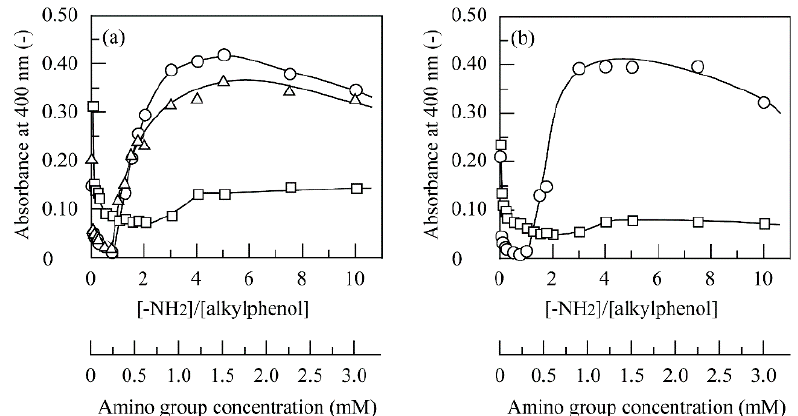
Figure 8. Changes in the absorbance at 400 nm with the amino group concentration for removal of ( a ) 4NBP ( ○ ), 4SBP ( △ ), and 4TBP ( □ ); and ( b ) 4NPenP ( ○ ) and 4TPenP ( □ )